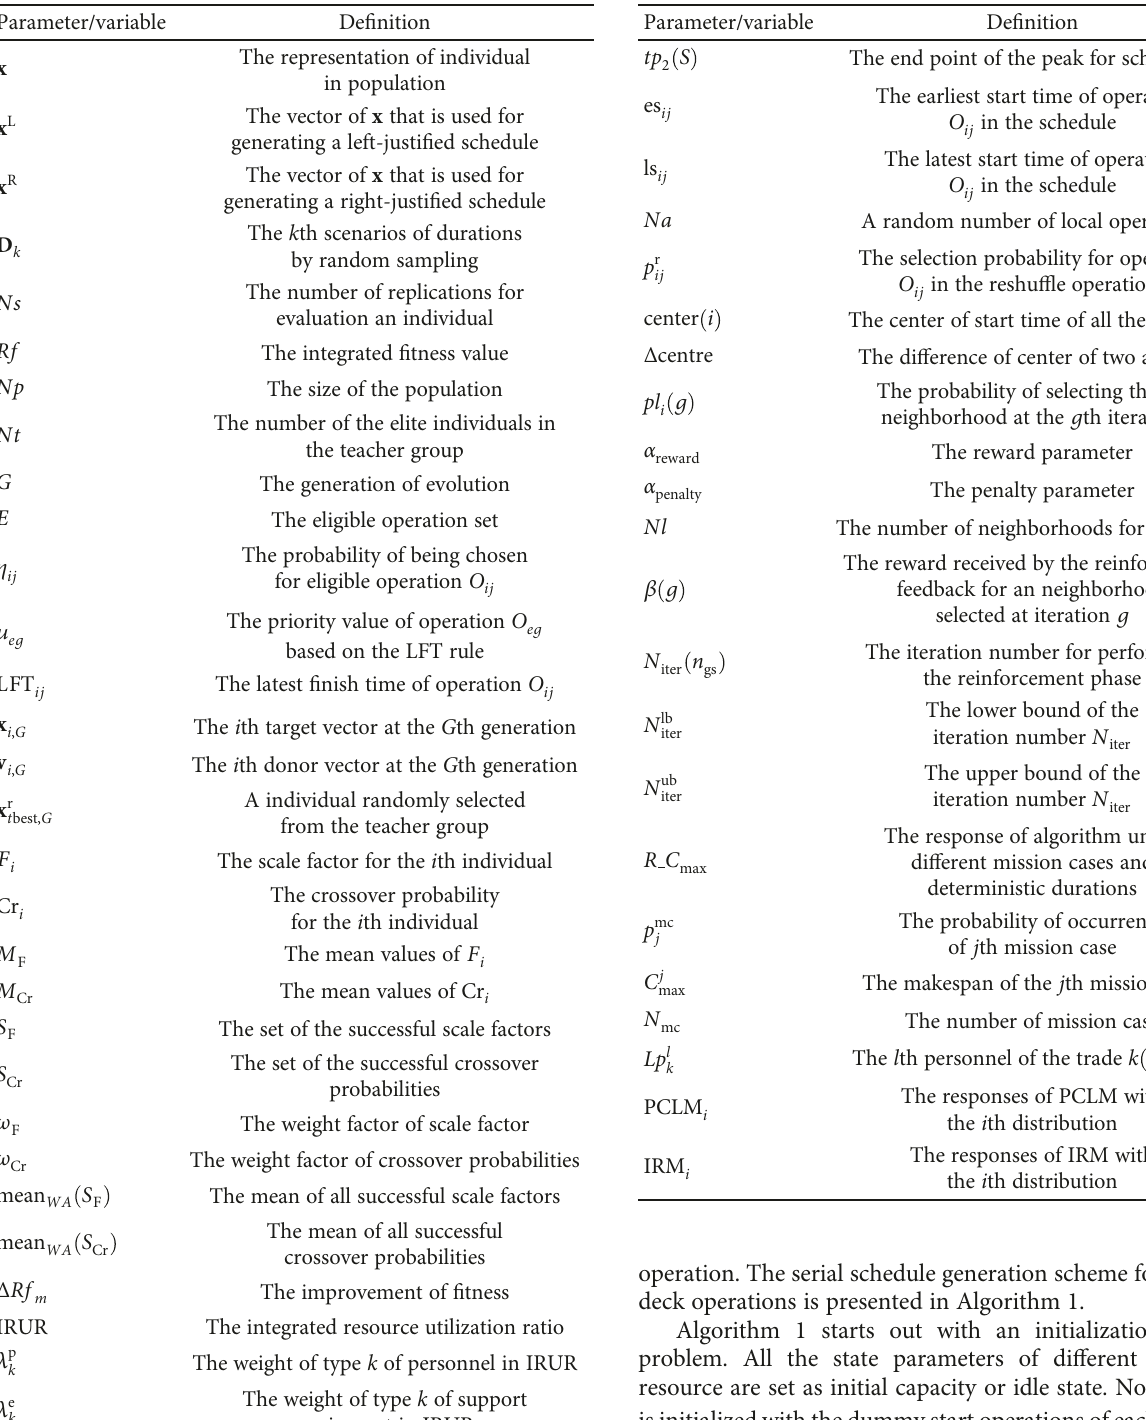
Table 4: Notation for optimization